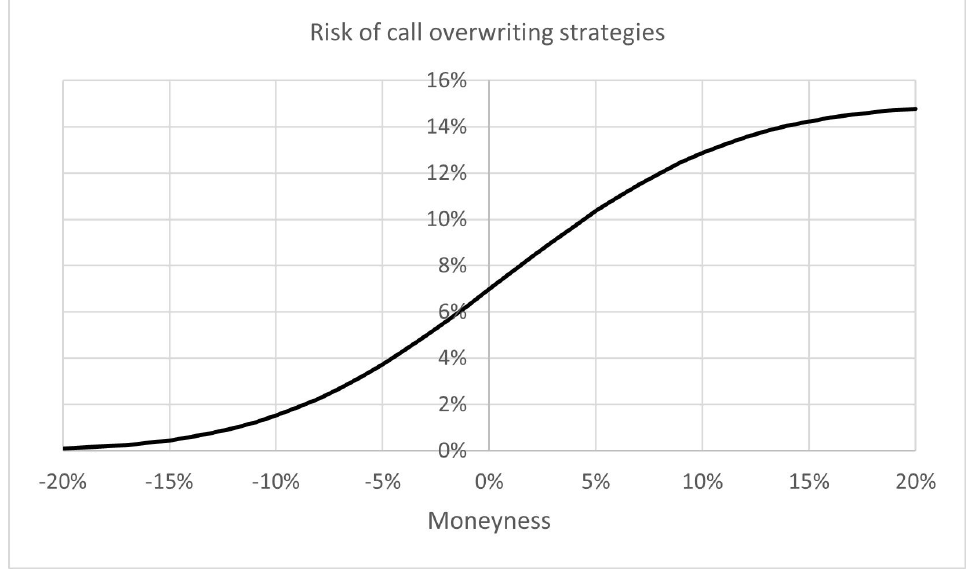
Figure 5. The risk of the return of an underlying asset with an overlaid call overwriting strategy for a range of strike